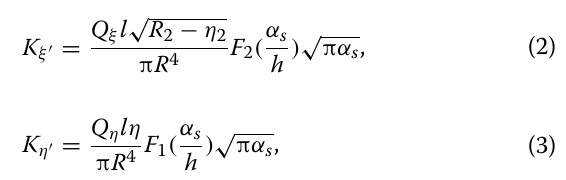
Figure 2(a) is the diagrammatic sketch of rotor system with a slant crack of 45°, and Figure 2(b) is the diagram- matic sketch of crack section. In Figure 2, XOY is the coordinate axis fixed at the shaft center. The four loads subjected to the shaft are respectively the axial force q 1 , the torque T , the bending moment q 4 and the bending moment q 5 in two directions.